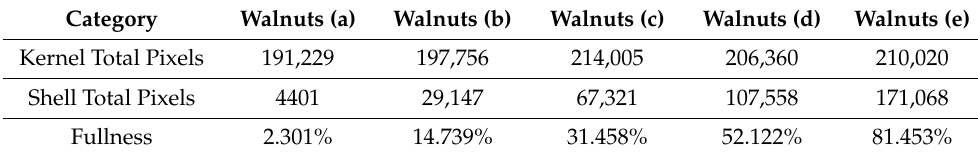
Table 4. Calculation results of walnut kernel fullness by walnut transmission images.